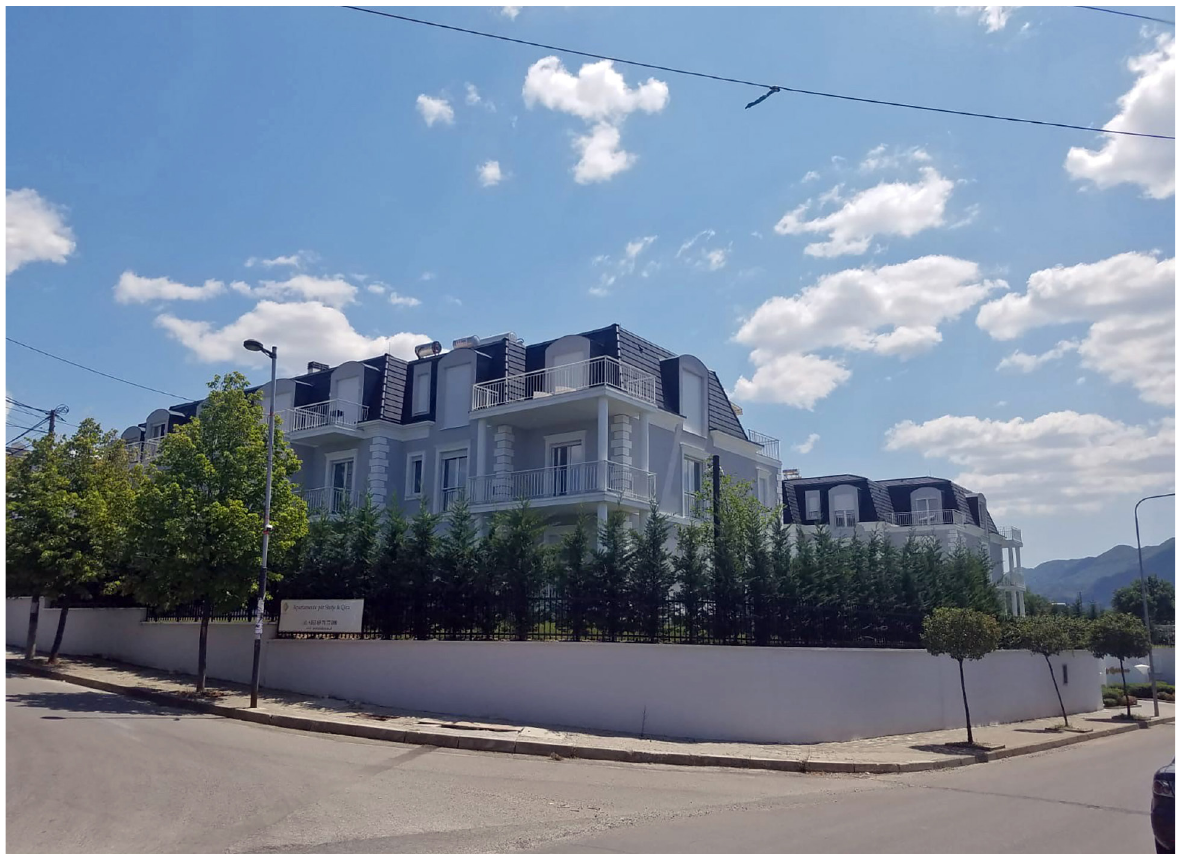
Fig. 2: Rolling Hills luxury Residences, Farka